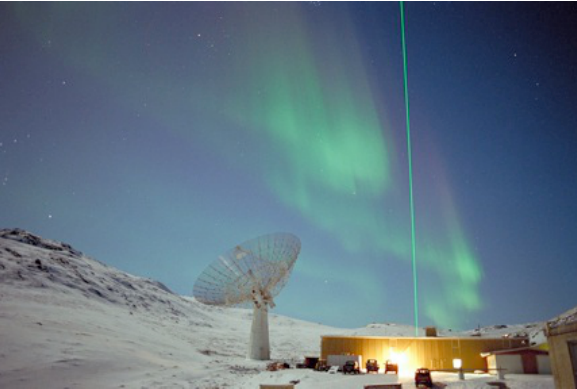
Figure 5. The Sondrestrom Upper Atmospheric Research Facil- ity, showing the 32m fully steerable parabolic dish, Rayleigh lidar beam and aurora on a moonlit night. Photo by C. Heinselman.